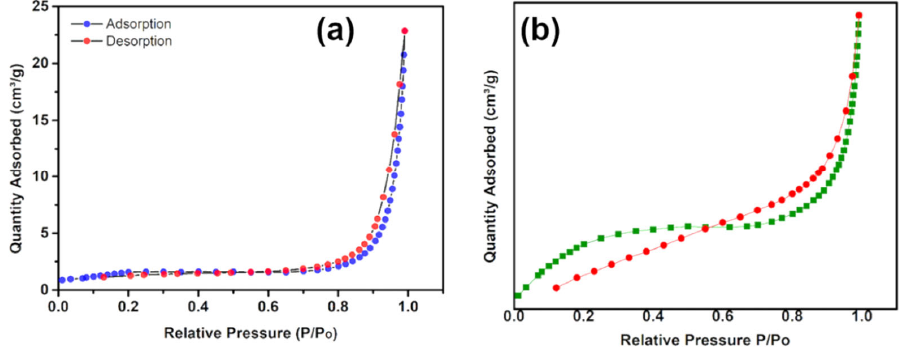
Figure 8. ( a ) Nitrogen linear adsorption isotherm of BFO and ( b ) nitrogen linear adsorption isotherm of CBB.